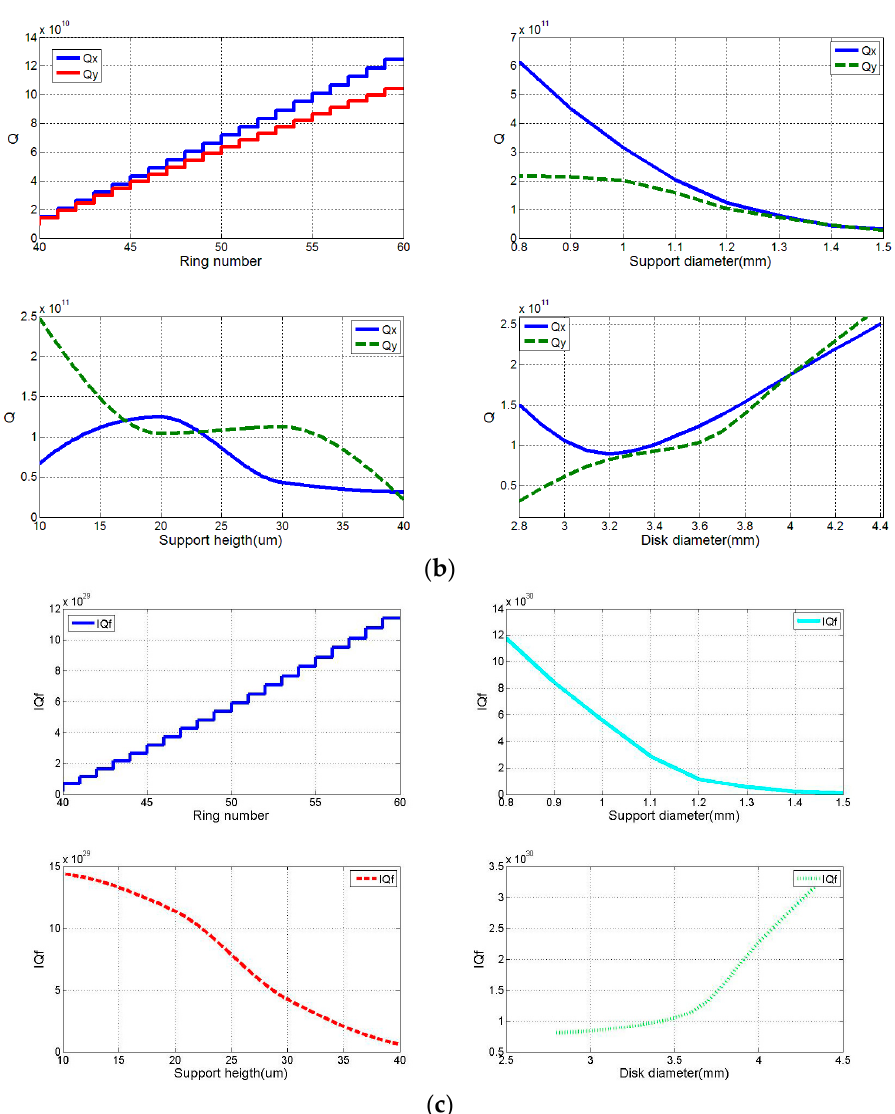
Figure 8. Simulation results of Q support in COMSOL Multiphysics: ( a ) The mesh result of DRG for simulation of support loss, ( b ) Simulation results of Q support in DRG, and ( c ) Simulation results of I Qf in DRG.